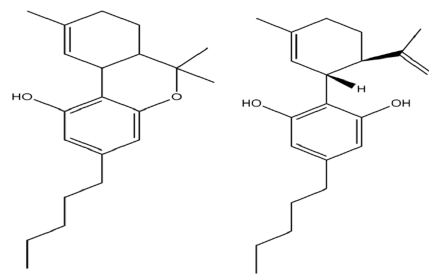
Figure 1. 2D ∆ 9-tetrahydrocannabinol structure and cannabidiol structure.